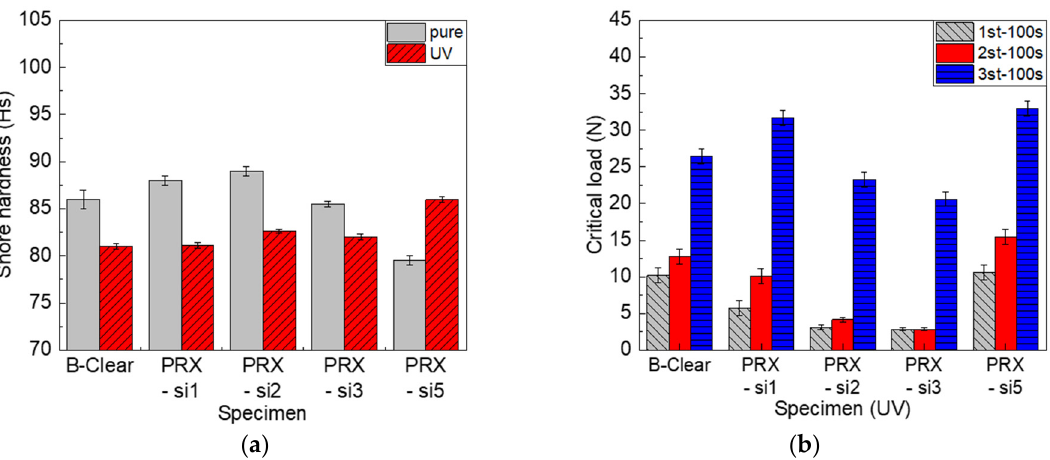
Figure 10. Effect of UV photodegradation with 61 MJ/m 2 UV irradiation for 400 h on Shore hardness ( a ) and scratch critical loads ( b ) of B-clear and PRX-Si specimens.